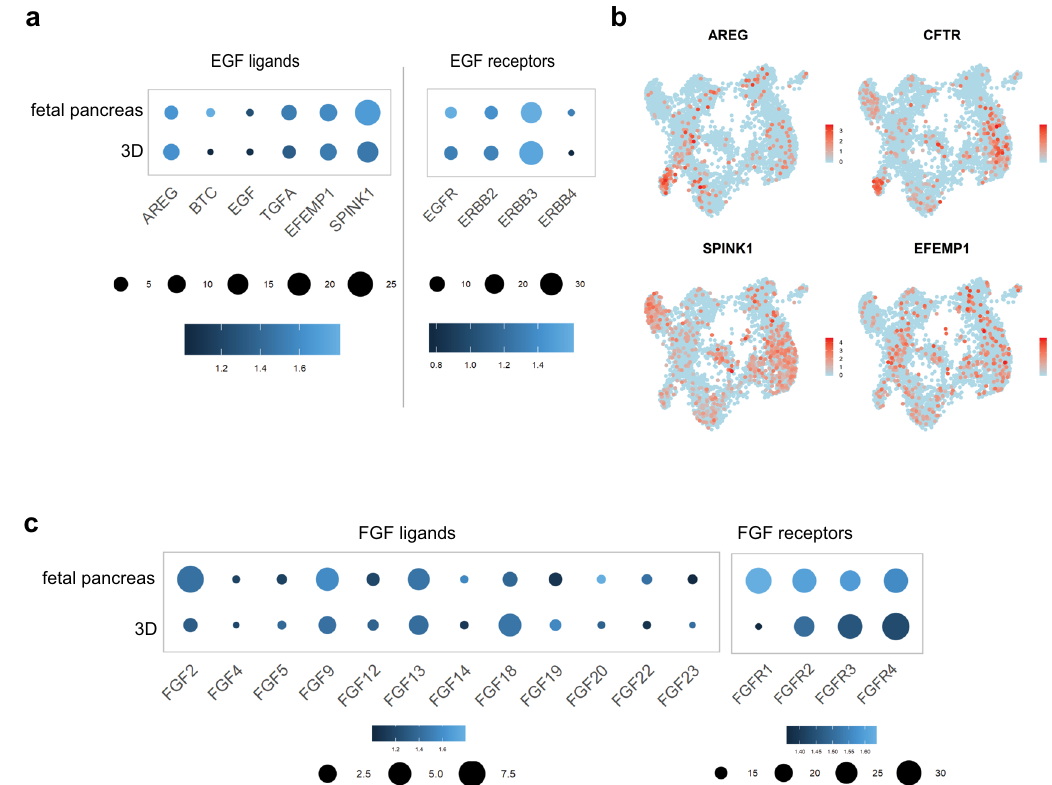
Fig. 7 Expression of EGF and FGF pathways components. a Dot plot depicting expression of relevant EGF ligands and receptors in pooled 3D samples — PP-spheroids and fetal spheres — and fetal pancreas samples. b Expression of selected gene markers overlapped on the global UMAP showing AREG expressing cells enriched in the ductal cluster. c Dot plot depicting expression of FGF ligands and receptors in 3D samples — PP-spheroids and fetal spheres — and fetal pancreas. Color intensity indicates mean expression in a cluster, dot size indicates the proportion of cells in a cluster expressing the